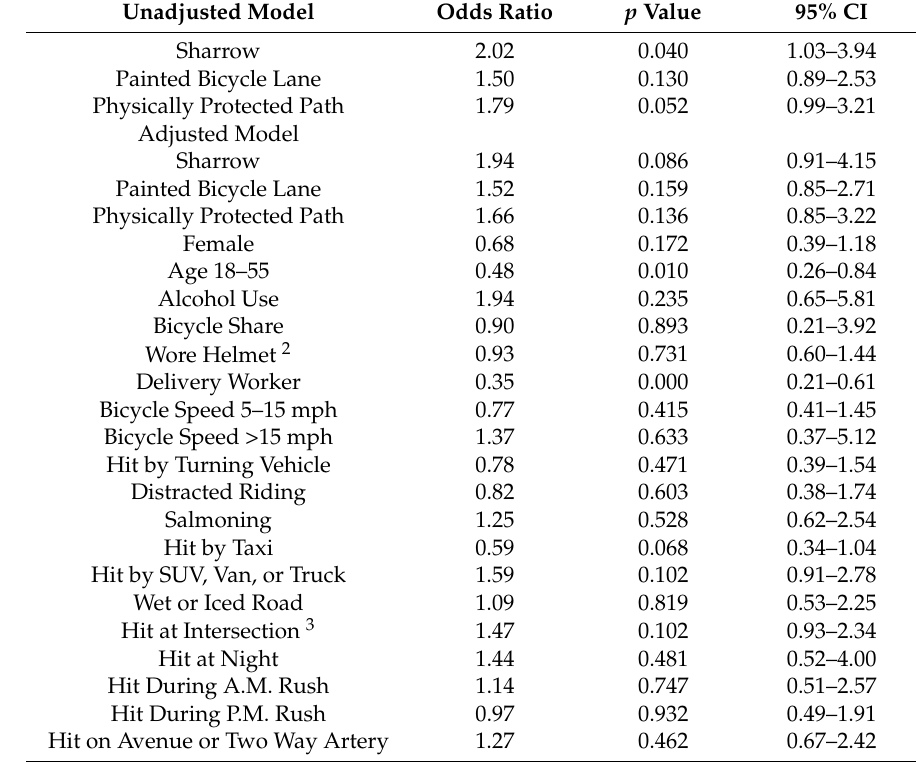
Table 3. Logistic Regression Modeling Injury Severity Score Categories 1